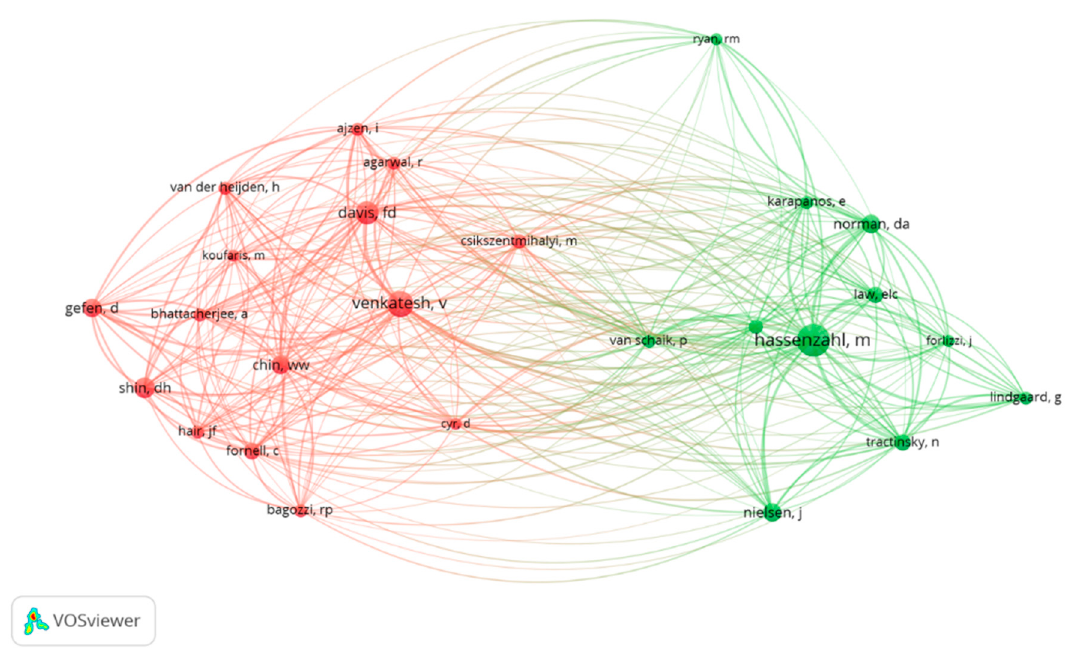
Figure 3. Author co-citation analysis. Source: Own elaboration based on VOSViewer.